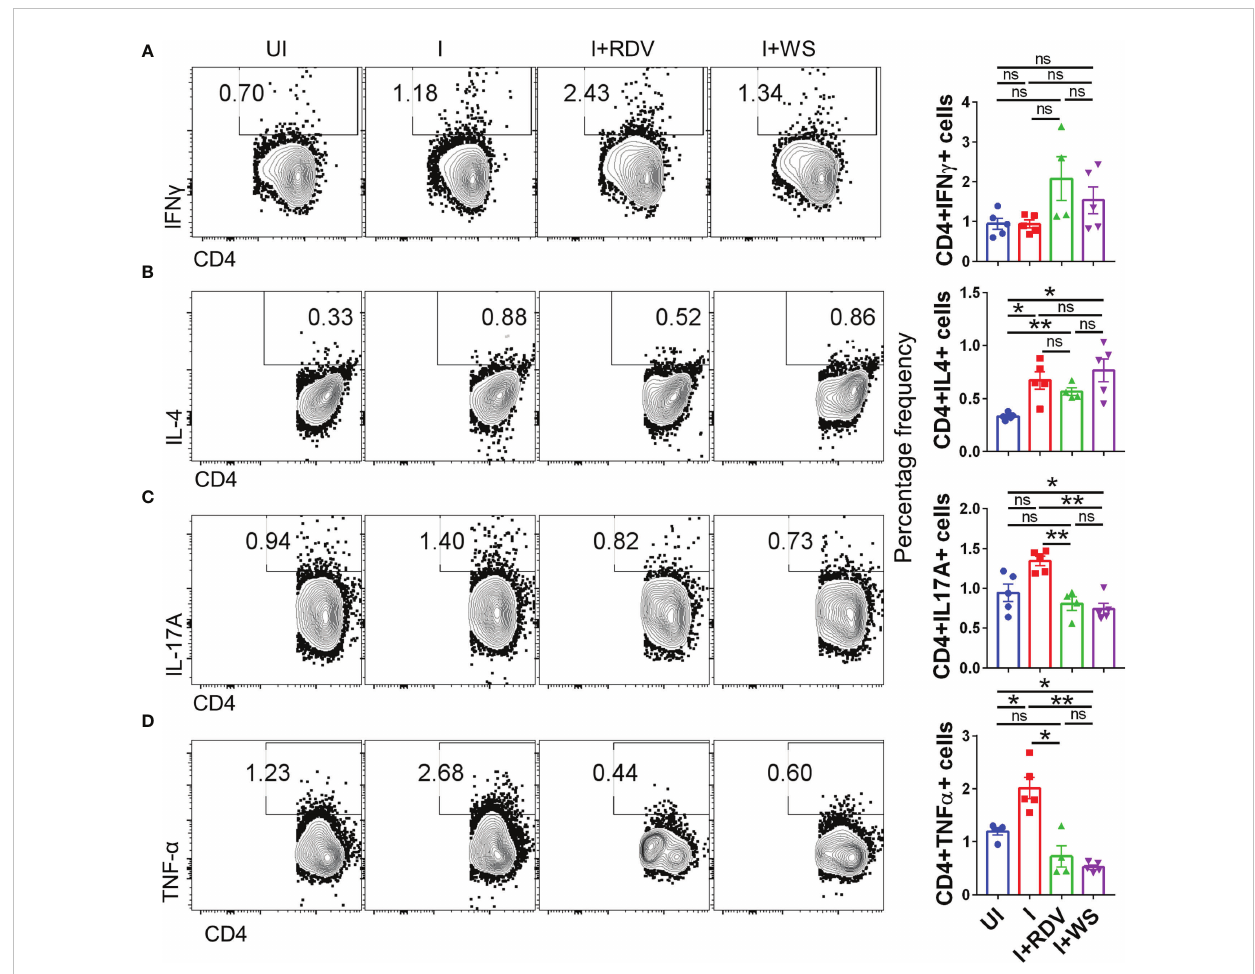
FIGURE 8 Changes in the effector cytokines of CD4+ T cells of infected hACE2 mice with or without treatment. Flow cytometry-based quantitation was done to evaluate changes in the major immune population in the lymph nodes of sacri fi ced animals at 6 dpi. The % age frequency was plotted as bar graph along with the representative contour plot (A) CD4+IFN g + cells (B) CD4+IL4+ cells (C) CD4+IL17A+ cells (D) CD4+TNF a + cells for each experiment N=5. One way-Anova using non-parametric Kruskal-Wallis test for multiple comparison. *P < 0.05, **P <